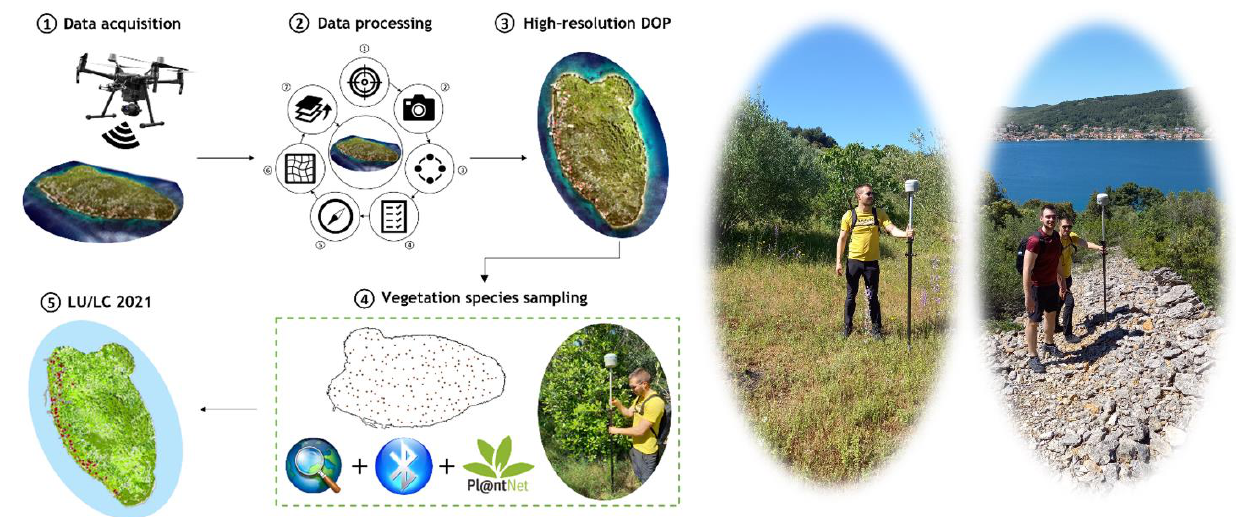
Figure 9. Methodological workflow for reference data acquisition.